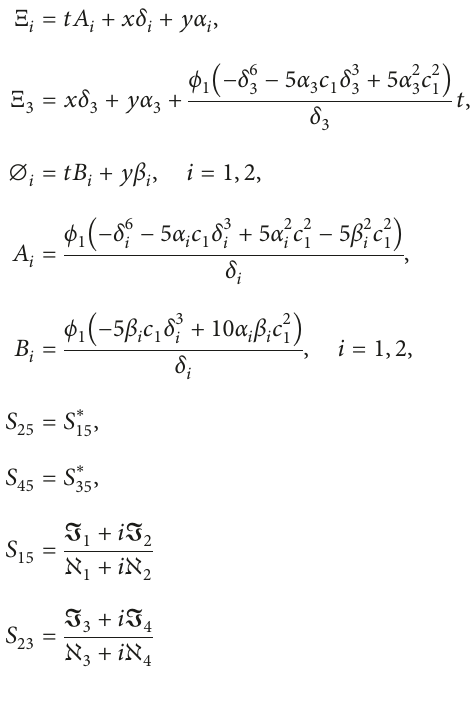
� 1 , c � 1/10, (a), (d) t � − 50. (b), (e) t � 0. (c), (f) t � 0 1